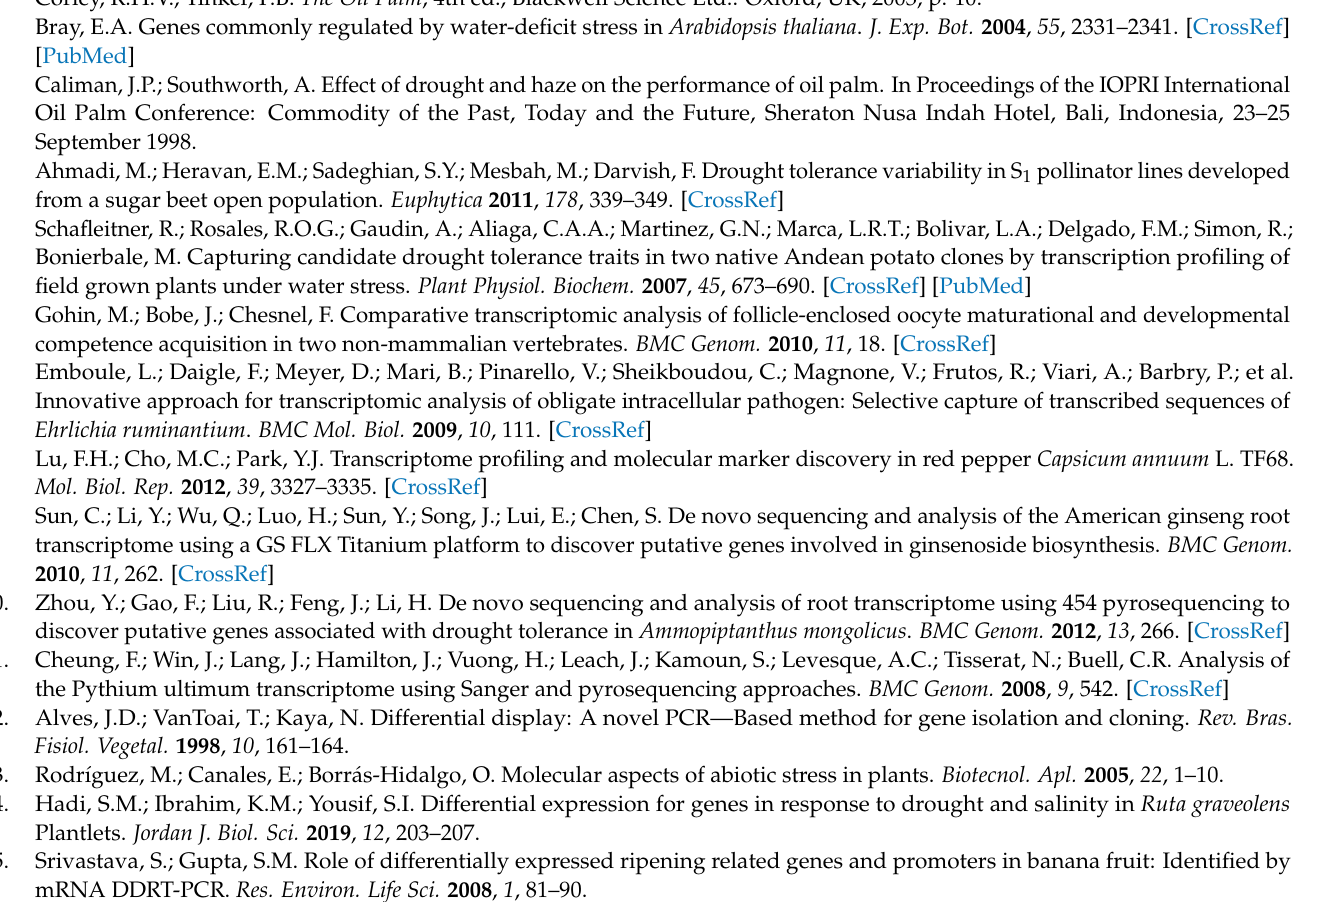
palm under water deficit for 45 days. Supplementary Table S5. Comparison of the expressed gene associated with drought tolerance from DDRT-RT and pyrosequencing database. Supplementary Table S6. Allele and genotype frequency of drought-tolerant and drought-sensitive separated by difference primers. Supplementary Table S7. The alignment of polymorphic EST-SSR primer with oil palm reference genome. Supplementary Table S8. Oligo (dT) primers and arbitrary primers sequencing for